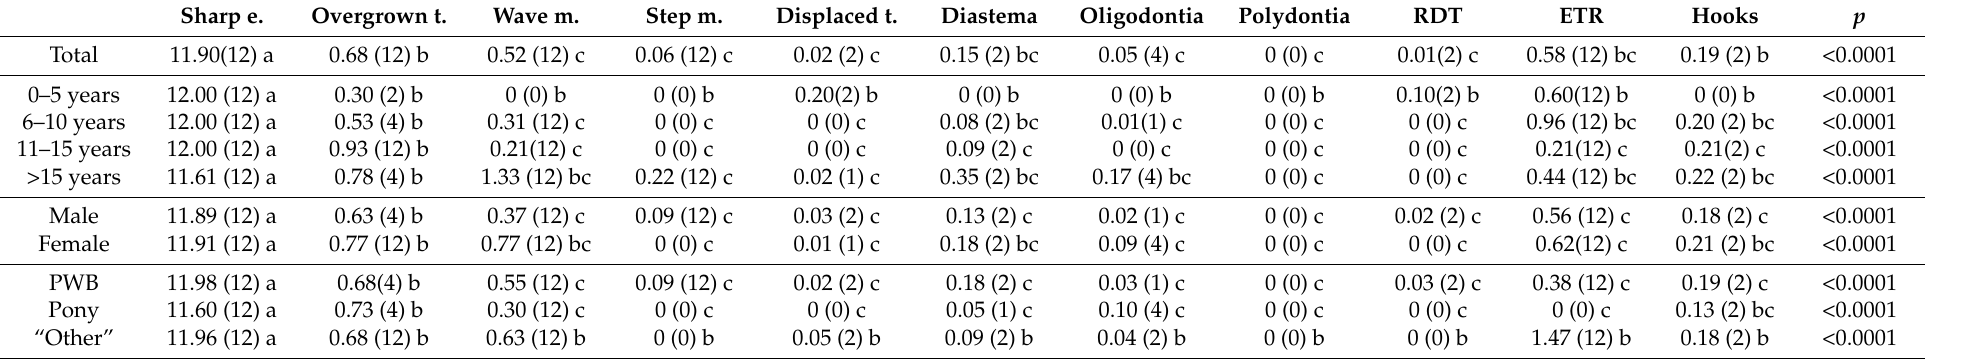
Table 8. The frequency distribution of malocclusions of premolar teeth in the total 7912 examined teeth of 206 horses. Sharp e. Overgrown t. Wave m. Step m.